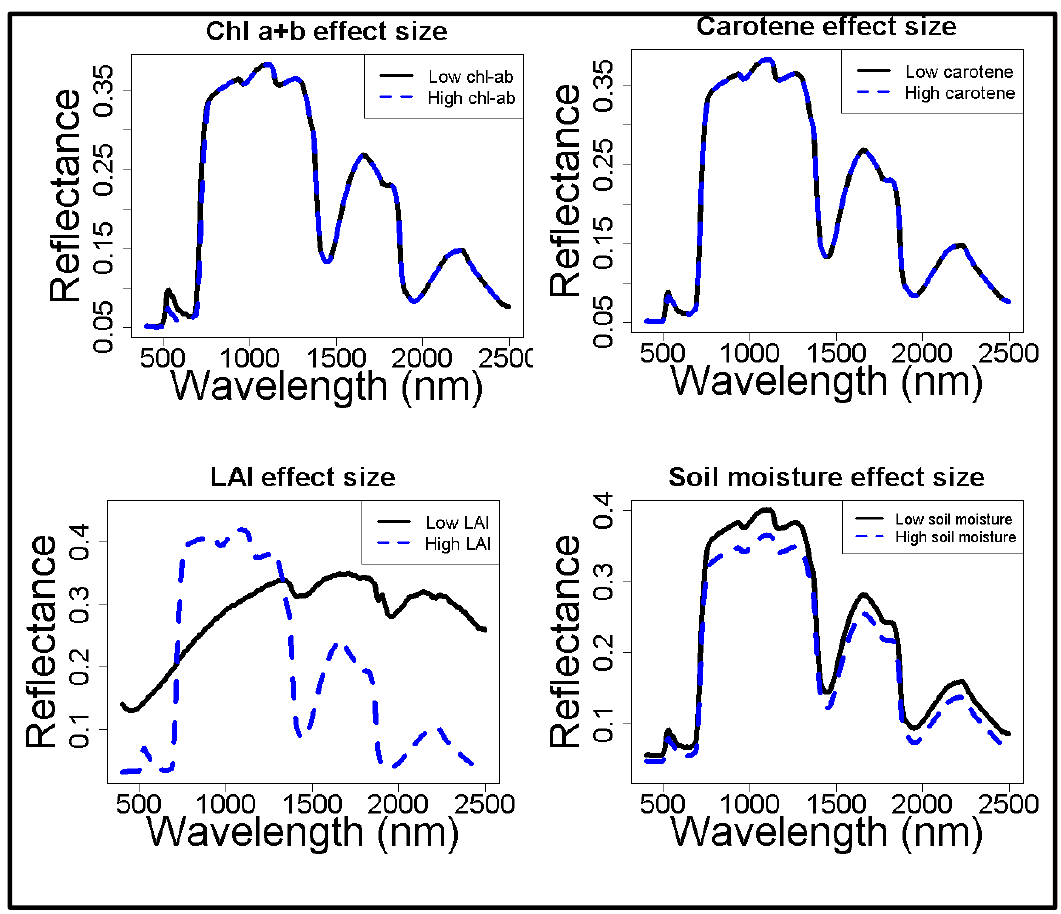
Figure 2. The effect of in situ observed ranges in vegetation properties on surface reflectance, based on simulations with ProSail. Surface reflectance is a fraction. The canopy properties (LAI and soil moisture content) have a much larger influence on reflectance than the leaf properties (Chlorophyll a+b and carotene).